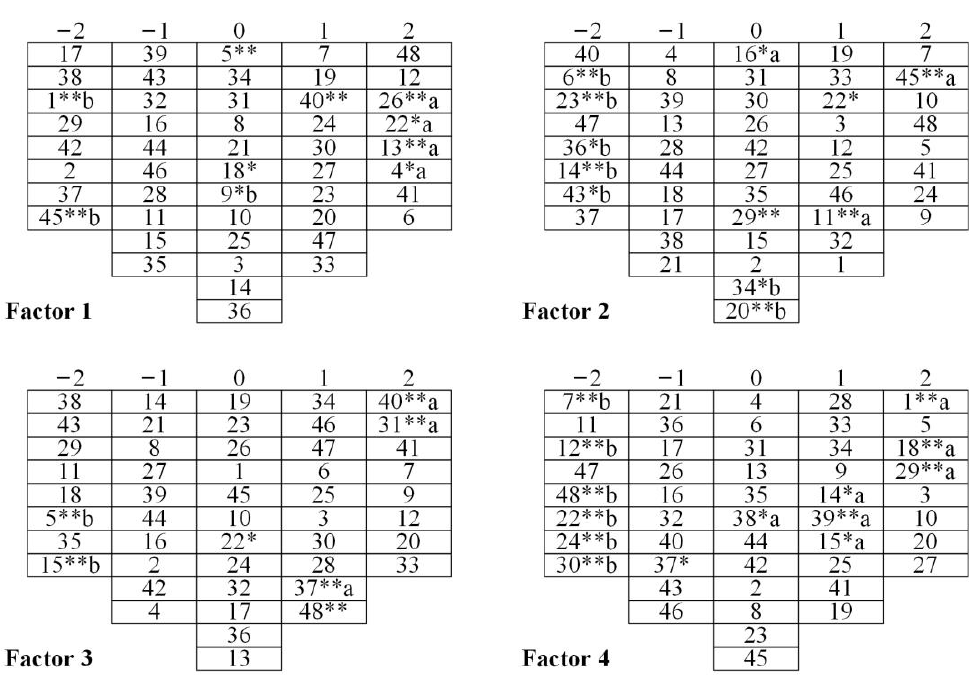
Figure 5. Q-sort of four factors. Note: * Distinguishing statement at p < 0.05; ** Distinguishing statement at p < 0.01. a: Z-Score for the statement is higher than in all other factors; b: Z-Score for the statement is lower than in all other factors.